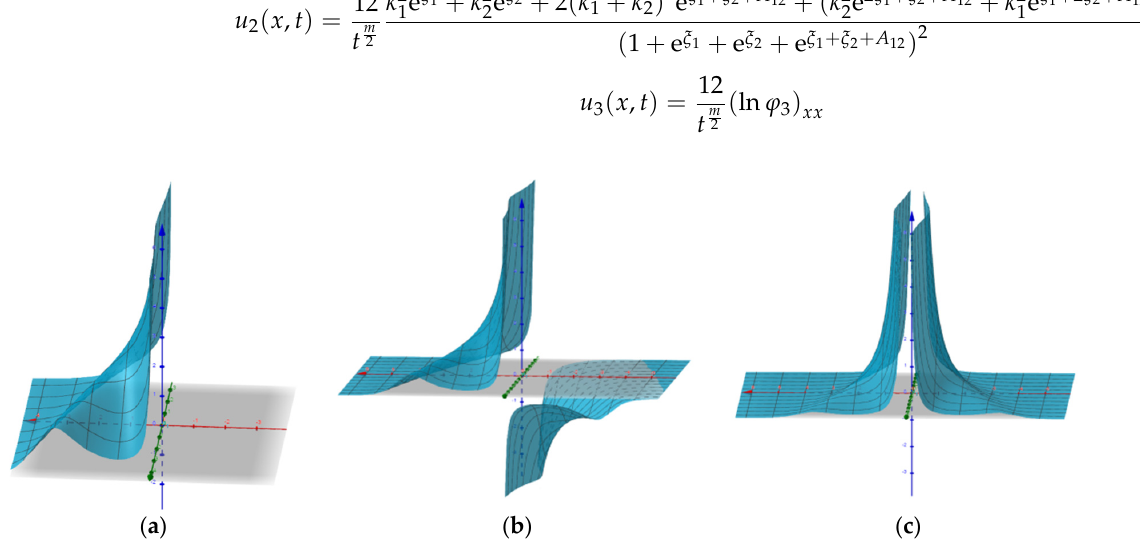
Figure 1. For the one soliton-like solution u 1 ( x , t ) , when f ( t ) = t , k = 1, the corresponding graphs of m = 1, m = 2 and m = 4 are given as above. ( a ) f ( t ) = t , k = 1, m = 1; ( b ) f ( t ) = t , k = 1, m = 2; ( c ) f ( t ) = t , k = 1, m = 4.